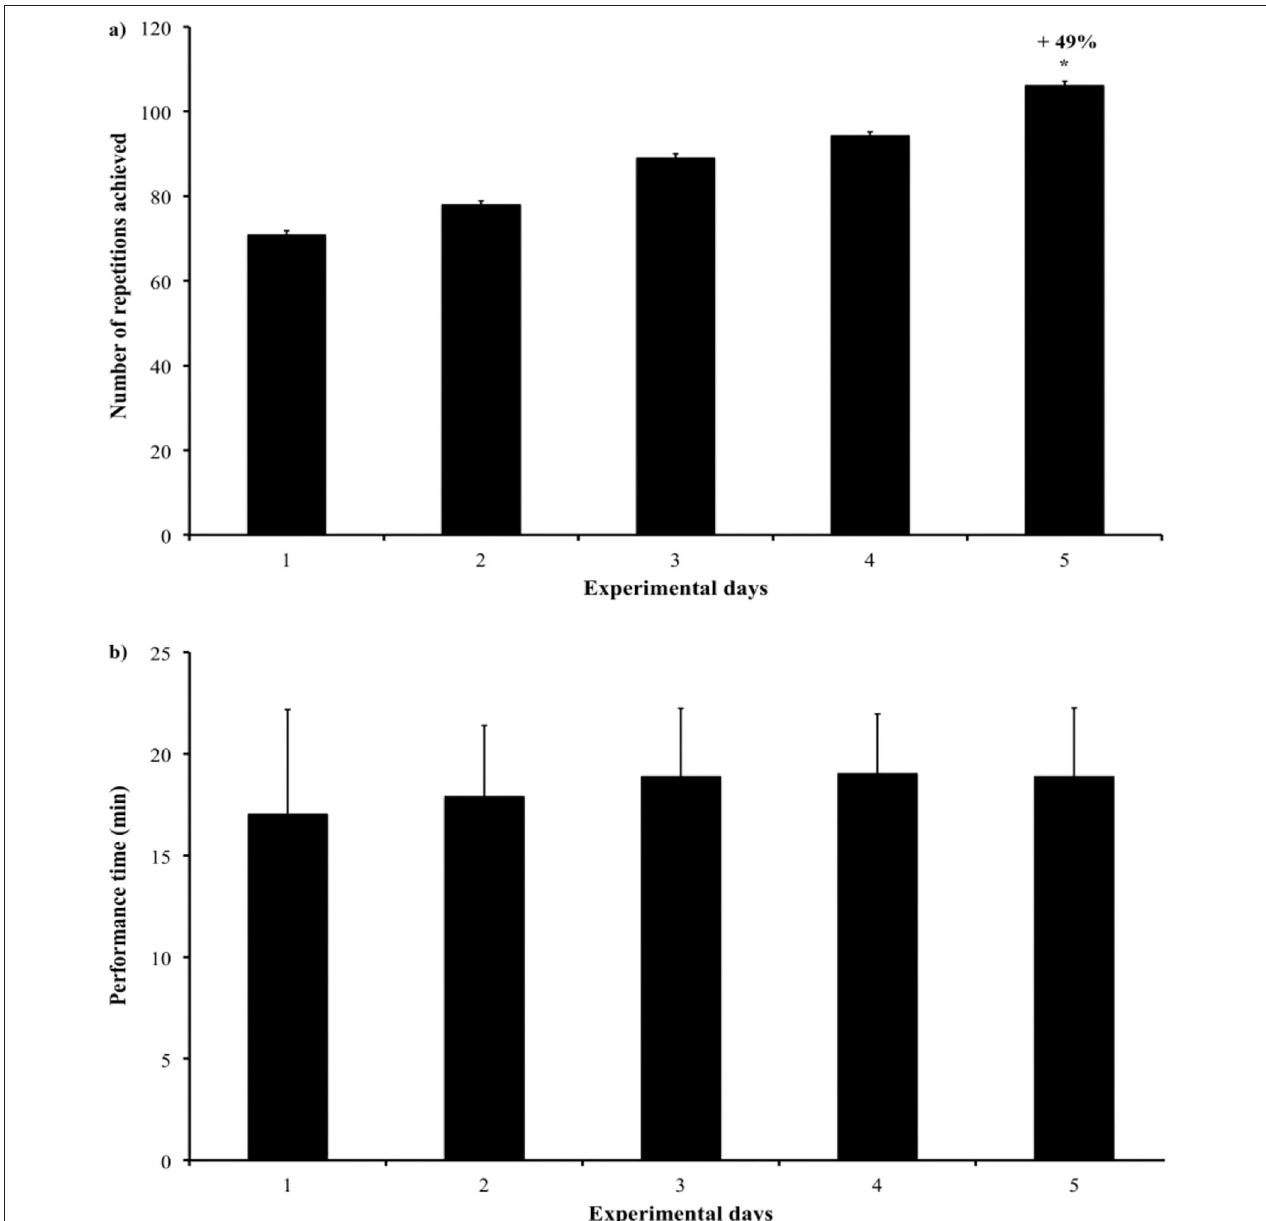
FIGURE 2 | (a,b) The number of repetitions achieved during the basic functional task lasted 20min per